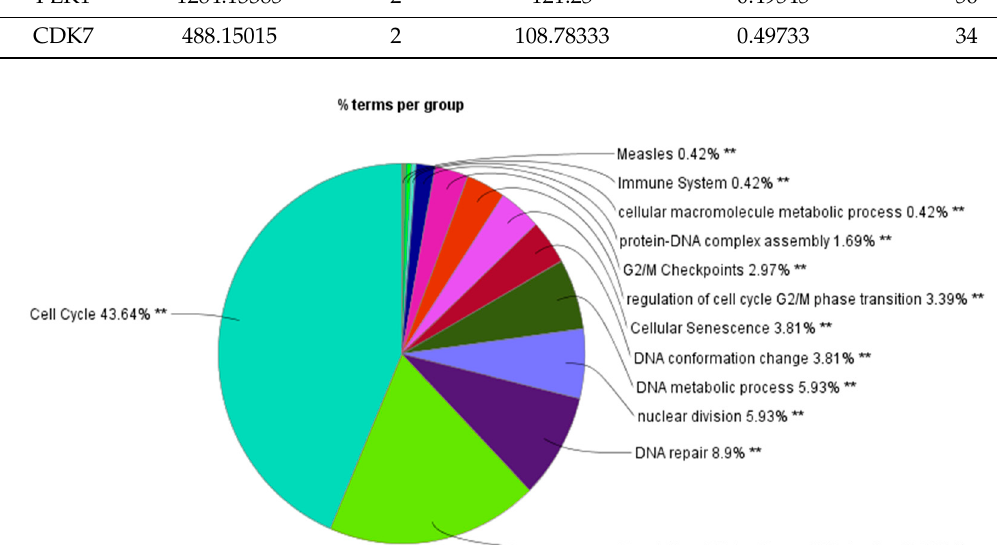
Figure 10. ClueGO results of gene ontology (GO) functional enrichment of key proteins.